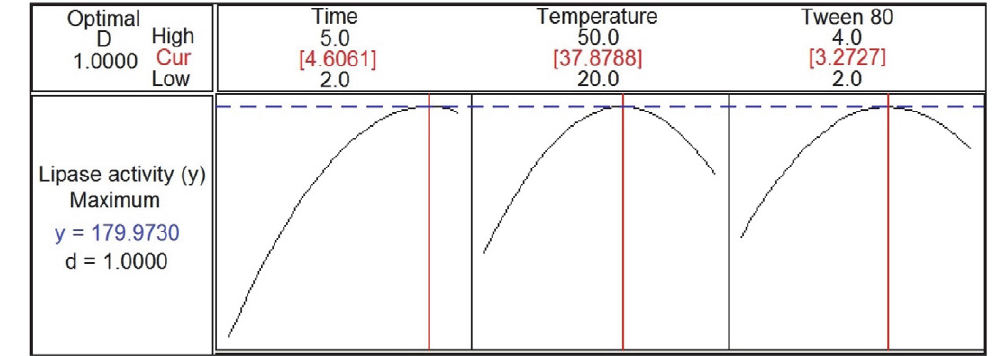
Figure 5 . Composite desirability and optimization plot for maximum lipase